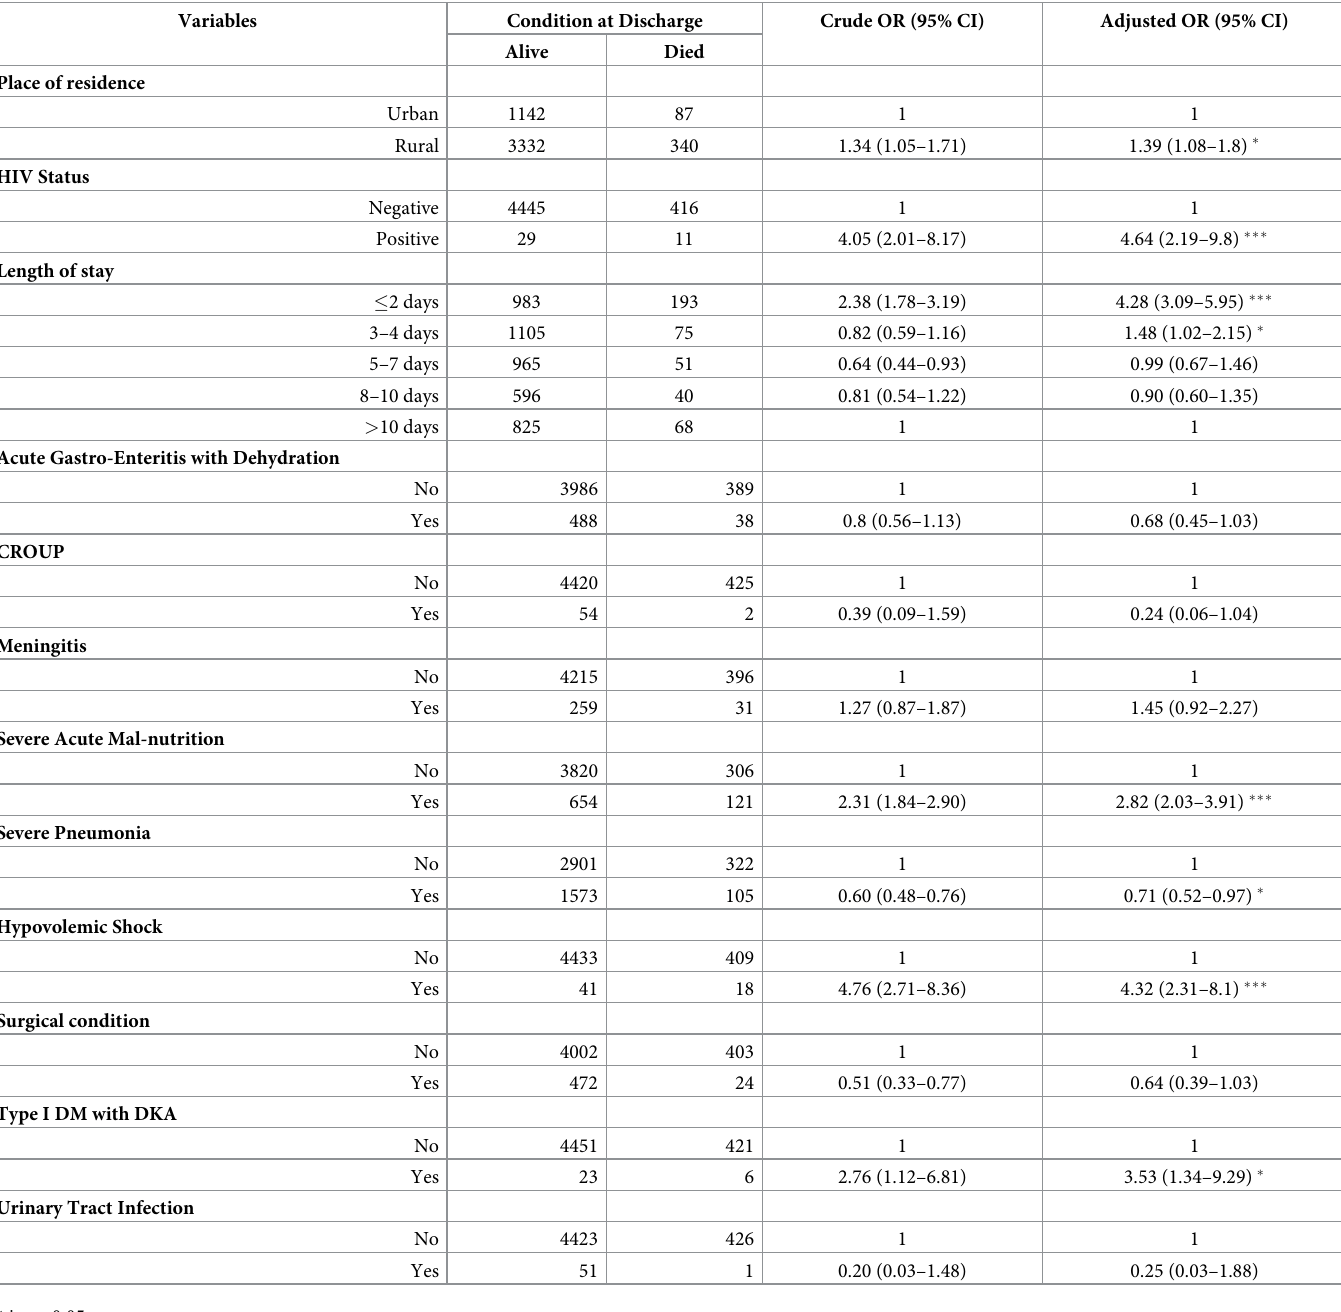
Table 4. Crude and Adjusted odds ratios for various factors in relation with condition at discharge among under-five children in Asella Teaching and Referral Hos- pital, January 2020.